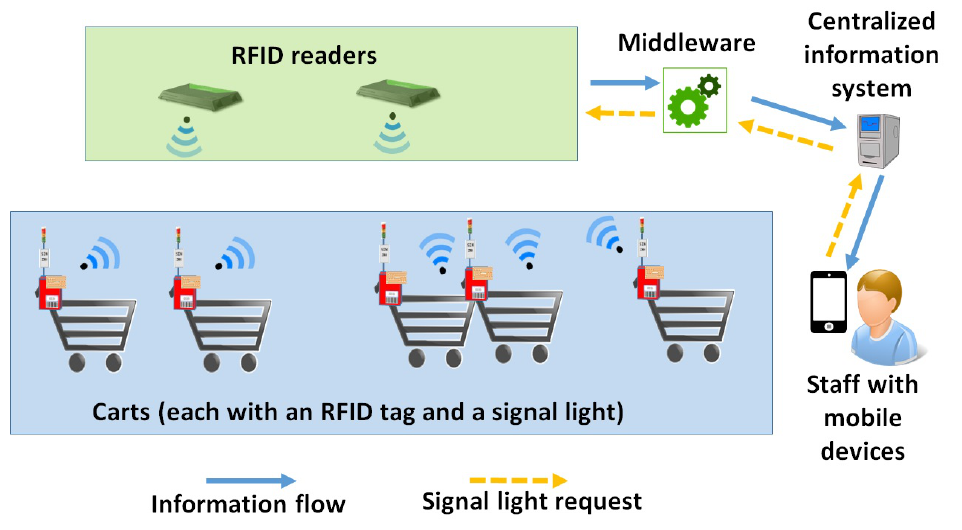
Figure 1. The key components of our proposed platform and its information